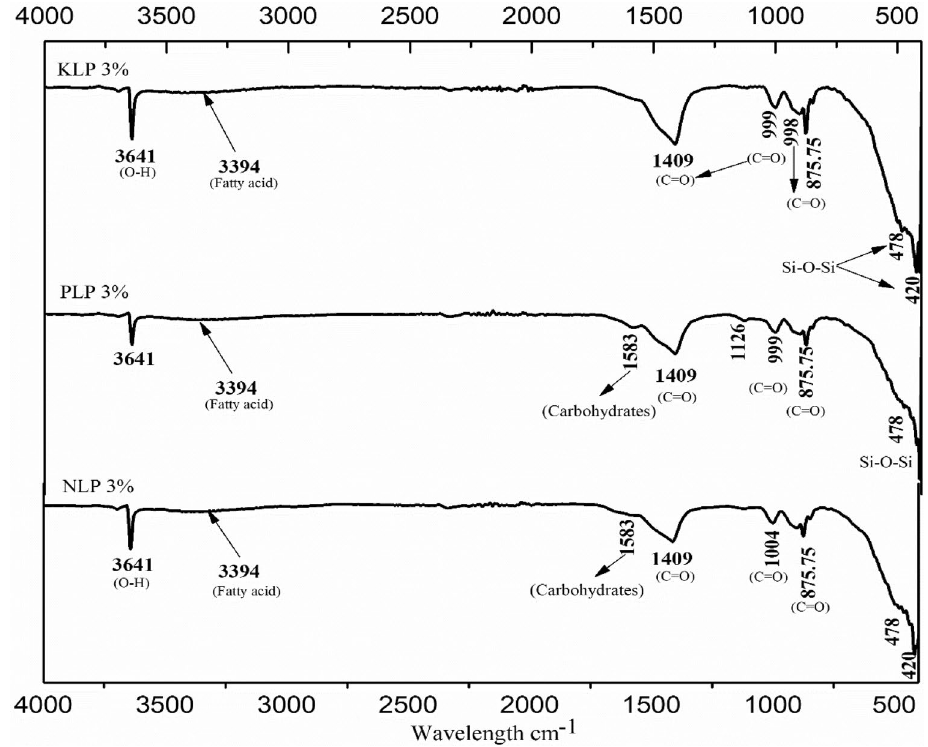
Figure 7. FT-IR organic spectrum of ( a ). Kadukkai lime putty ( b ). Palm jaggery lime putty ( c ). Neelamari lime